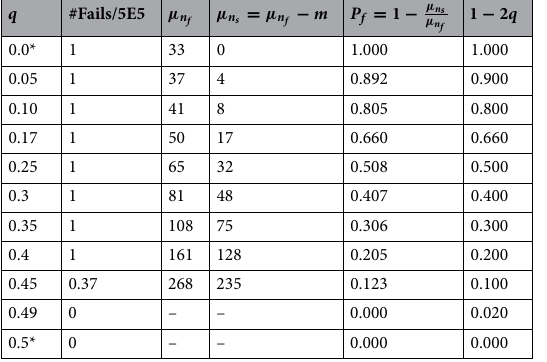
Table 1. Results of numerical simulations. *Simulations were not run for these limiting cases. µ n from N × M = 500,000 simulations µ n reaching mm